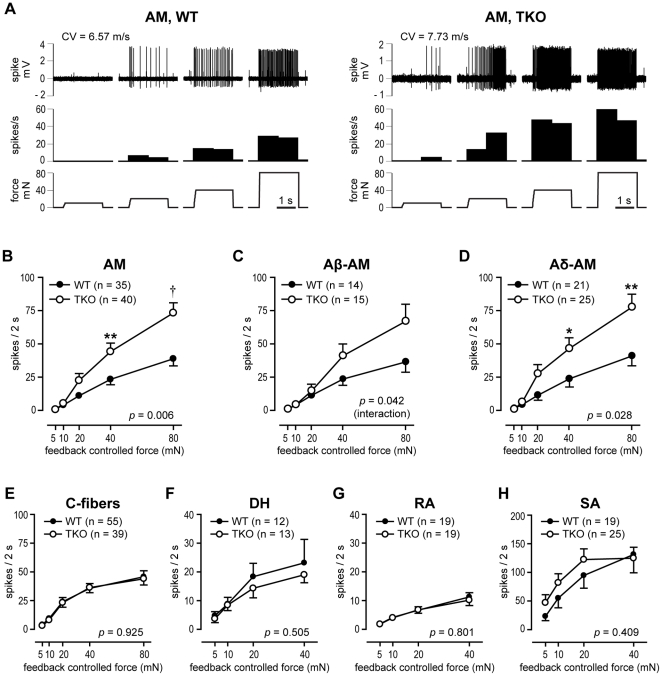
Mechanosensitivity of cutaneous primary afferents in ASIC triple-knockout (TKO) and wild-type (WT) mice.
A, Sample recording traces showing responses of A-mechanonociceptors (AM) from WT and ASIC TKO mice to mechanical stimuli. The upper, middle and lower panels show the digitized oscilloscope tracing, the spike density histograms (bin width  =  1 s), and the force stimuli applied, respectively. CV  =  conduction velocity. B, Stimulus-response function of AM from ASIC TKO (n  =  40, ○) vs. WT (n  =  35, •), showing enhanced mechanosensitivity in ASIC TKO mice (p  =  0.006 between genotypes by two-way ANOVA with repeated measures on one factor. **p < 0.01; †p < 0.001 vs. WT by unpaired t-test). C, D, When AM fibers were subclassified based on CV, not Aβ-AM (C) but Aδ-AM (D) showed a significant increase in the stimulus-response function in ASIC TKO mice (p  =  0.028 between genotypes by two-way ANOVA with repeated measures on one factor. *p < 0.05; **p < 0.01 vs. WT by unpaired t-test). E-H, Stimulus-response function of C-fibers (E), D-hair receptors (DHs) (F), rapidly adapting (RAs) (G), and slowly adapting low-threshold mechanoreceptors (SAs) (H). Data are presented as mean ± SEM.